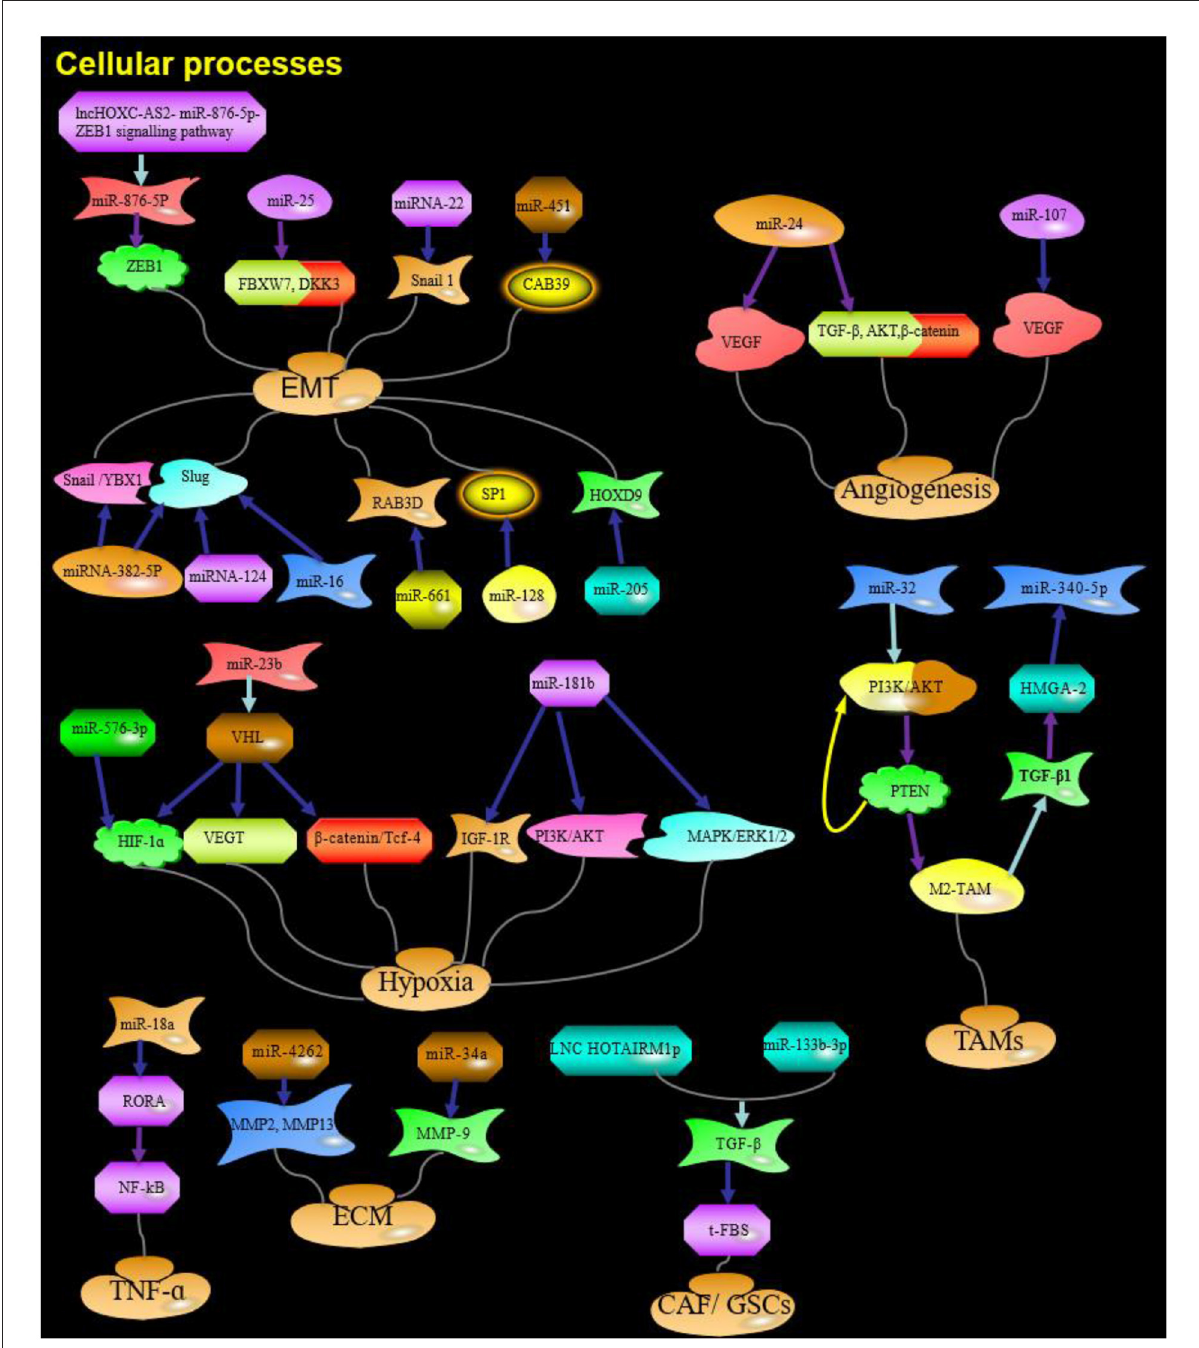
FIGURE2 The role and targets of miRNA in cellular processes of glioma. Purple arrow indicates promotion; Blue arrows indicate suppression; Red arrows indicate positive feedback; Yellow arrows indicate negative feedback; Water green arrow indicates adjustment; ZEB1, zinc finger E-box binding homeobox 1;ZEB2, zinc finger E-box binding homeobox 2; F-box, F-box-containing; FBXW7, F-box-containing and WD repeat domain 7; DKK3, Dickkopf Wnt signaling pathway inhibitor 3; YBX1, Y box binding protein 1; HIF-1 α , Hypoxia-inducible factor 1a; IGF-1R, insulin-like growth factor 1 receptor; HGS, hepatocyte growth factor-regulated tyrosine kinase substrate; TGF- β , transforming growth factor; PTEN, Phosphatase and tensin homolog; RORA, Retinoic acid receptor-related orphan receptor A; HOTAIRM1, HOXA transcript antisense RNA, myeloid-specific 1; ECM, extracellular matrix; Red and yellow arrows: